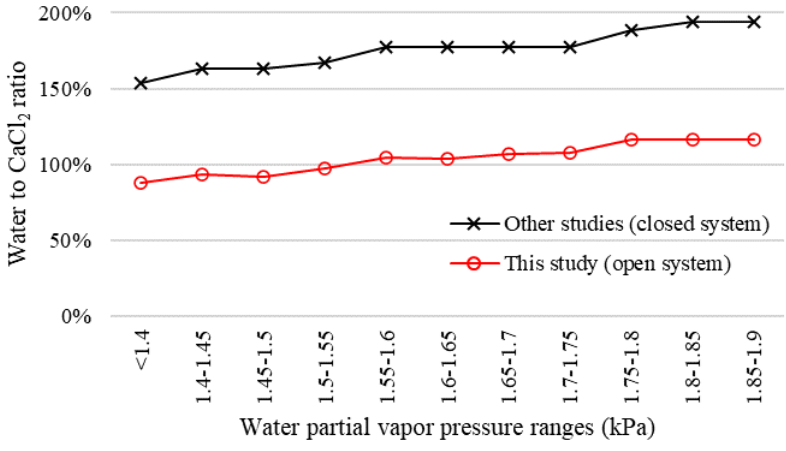
Figure 7. A comparison of water content measurements with the phase diagram in other studies [30,31].